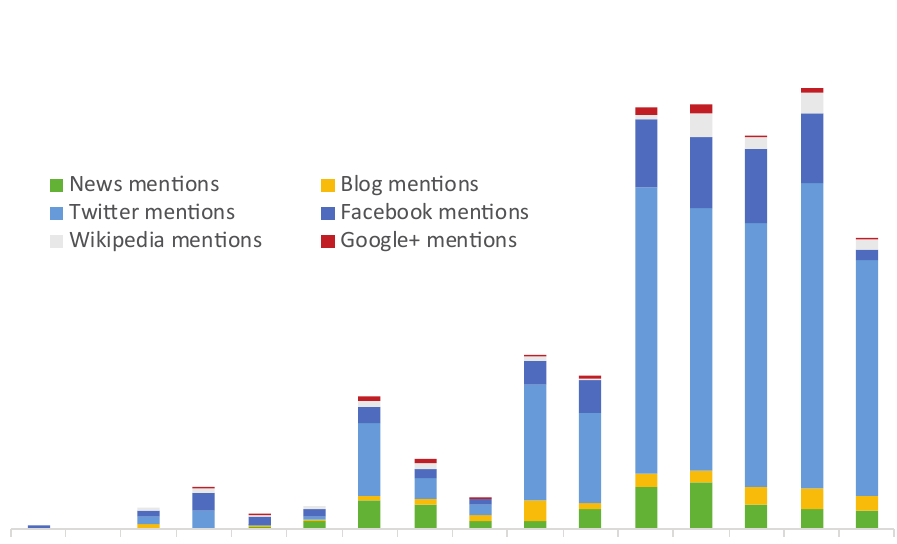
Figure 2. Total number of PhytoKeys mentions in social media and popular